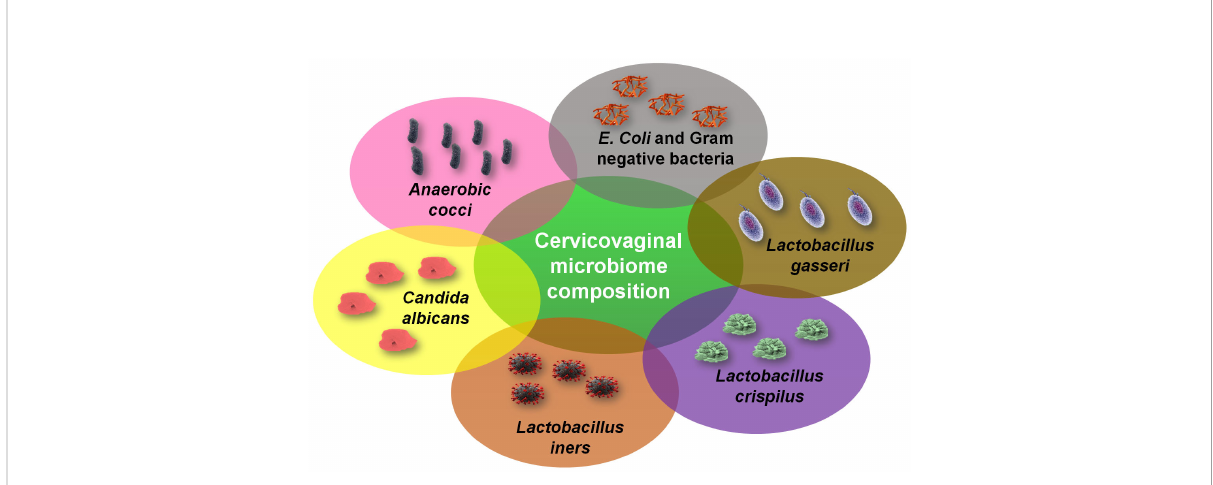
FIGURE 5 The cervicovaginal microbiome composition. The cervical fl uid contains different types of microbiotas called as the cervicovaginal microbiome that mainly include Anaerobic cocci , Candida albicans and different species of Lactobacillus